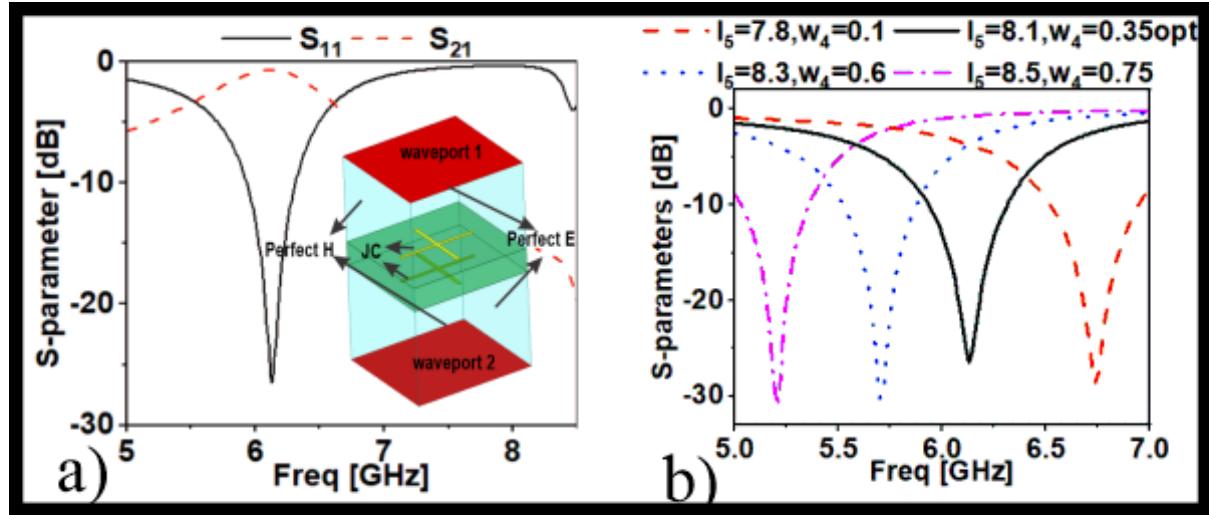
Figure 3. FSS-based JC: ( a ) analysis; ( b ) parametric variation.